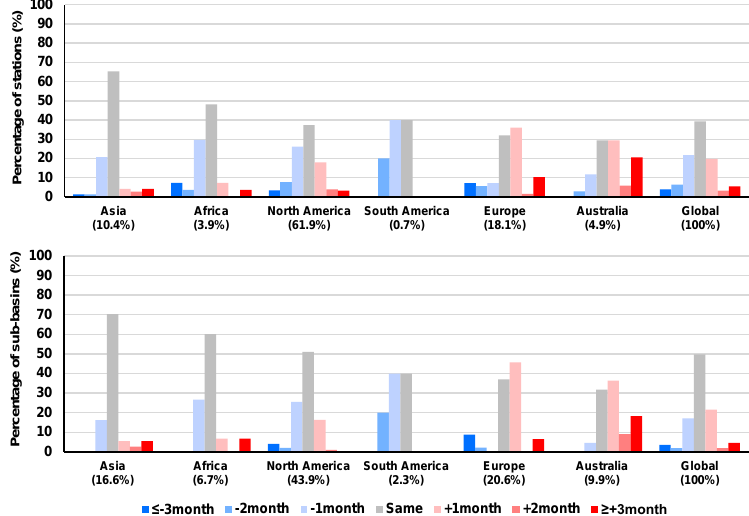
Figure 7. Percentage of stations (top panel) and sub-basins (bottom panel) according to the temporal difference of PM between observations and model outputs (SM–OB, number of months) in each continent.